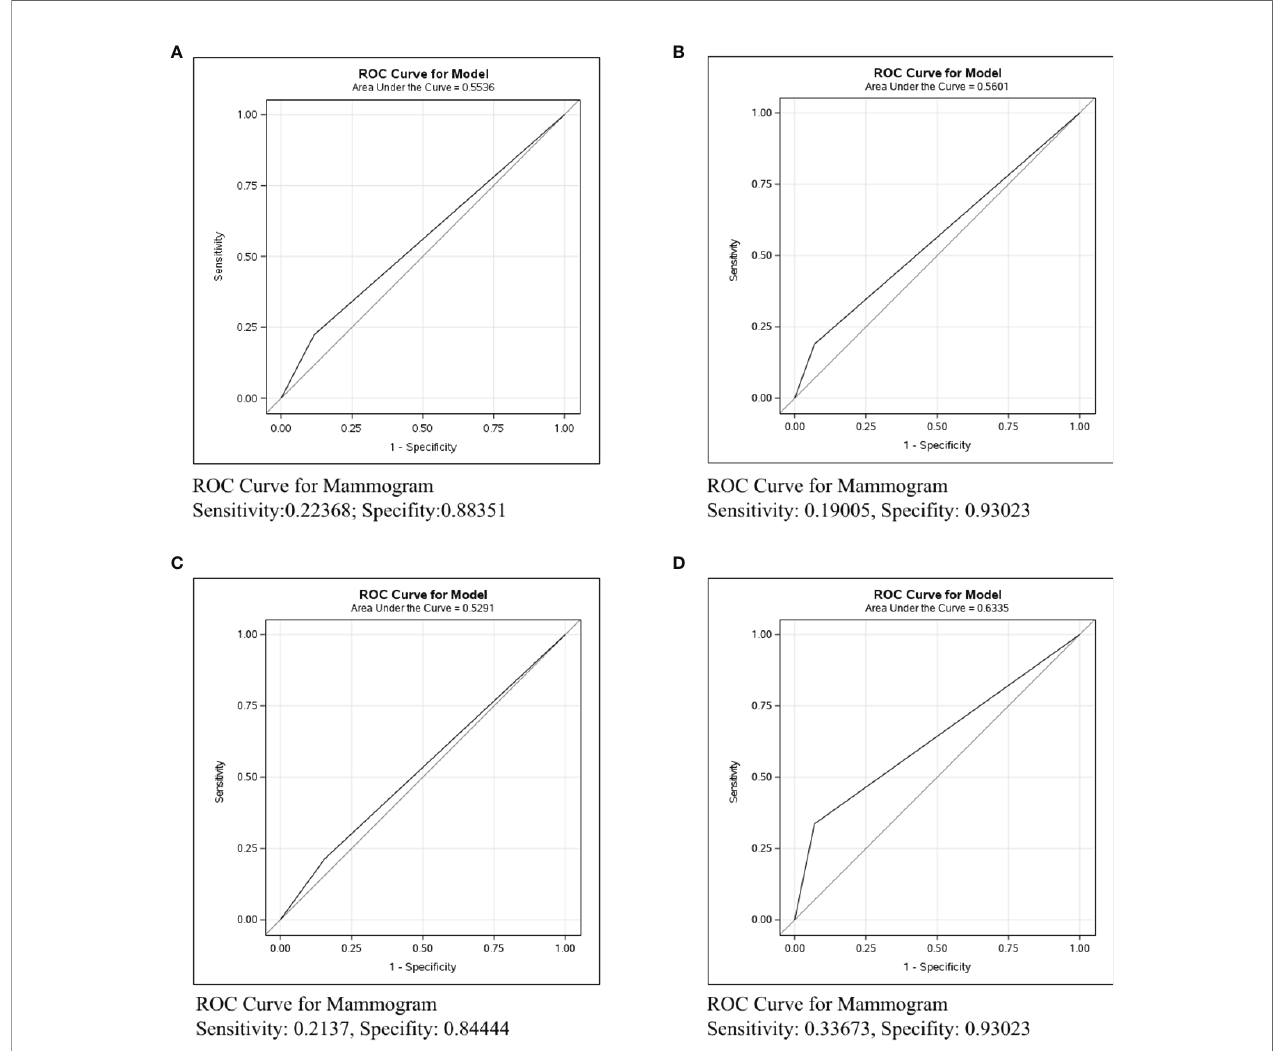
FIGURE 5 | ROC curve analysis for Mammogram in all molecular subtypes. The vertical axis is sensitivity, the horizontal axis is 1-speci fi city. AUC is a parameter used to measure the value of mammogram in the prediction of axillary lymph nodes. (A) ROC curve in all molecular subtypes. (B) ROC curve in ER/PR+Her2- negative subtype. (C) ROC curve in Her2+ subtype. (D) ROC curve in ER/PR-Her2-